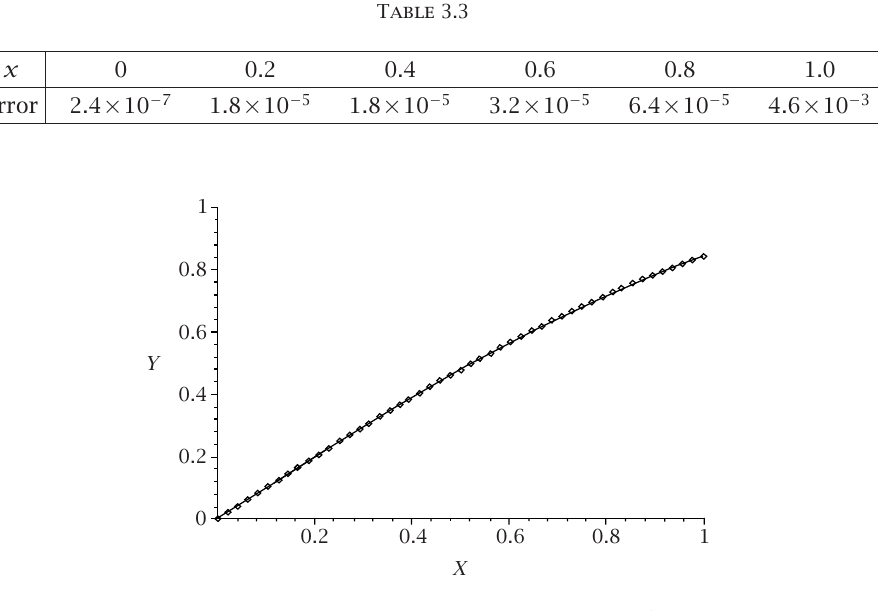
Figure 3.3 . Decomposition method versus analytic solution for y(x) = x